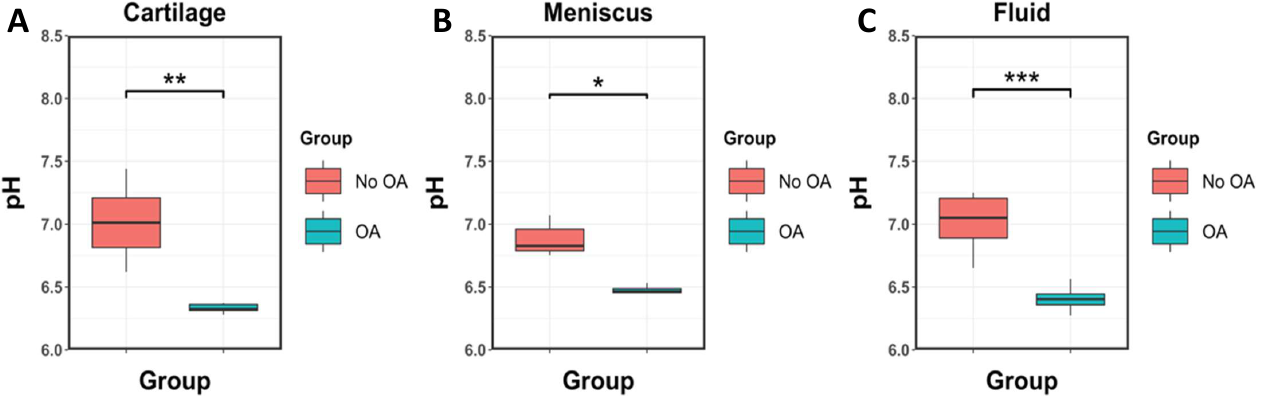
Figure 3. Boxplots of mean pH measurements versus each group of participants (No OA and OA) for ROIs drew in cartilage ( A ), meniscus ( B ), and fluid ( C ). Significant differences in pH measurements are observed between groups with lower pH in patients with OA compared with patients without OA. “***”: p values lower than 0.001; “**”: p values lower than 0.01; “*”: p values lower than 0.05.